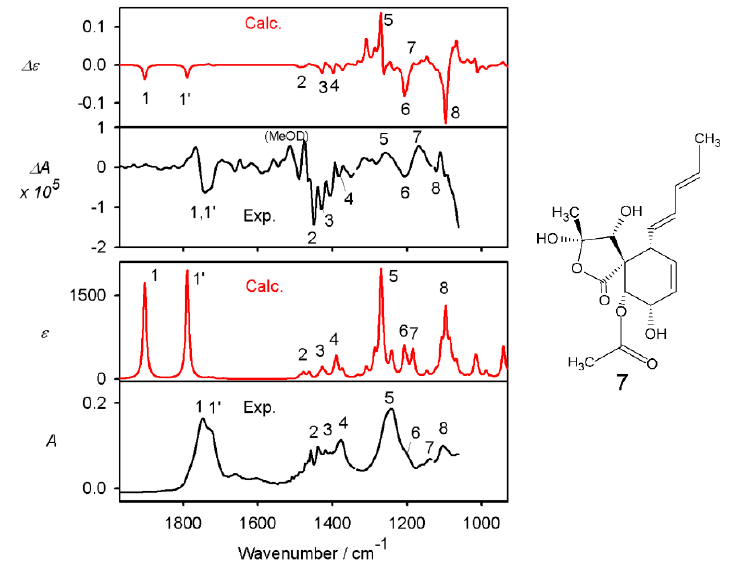
Figure 5. Calculated (red) and experimental (black) VCD (top) and IR (bottom) spectra of 7 , and the structure including annotation of the absolute configuration of 7 as used for the calculation. For easier orientation, corresponding bands are numbered. The large shift between the carbonyl vibrations (1 and 1’, calc. vs. exp.) is caused by the approximate solvent model in the calculations; the other two most intense IR bands (5 and 8) largely involve OH bending and CO stretching.